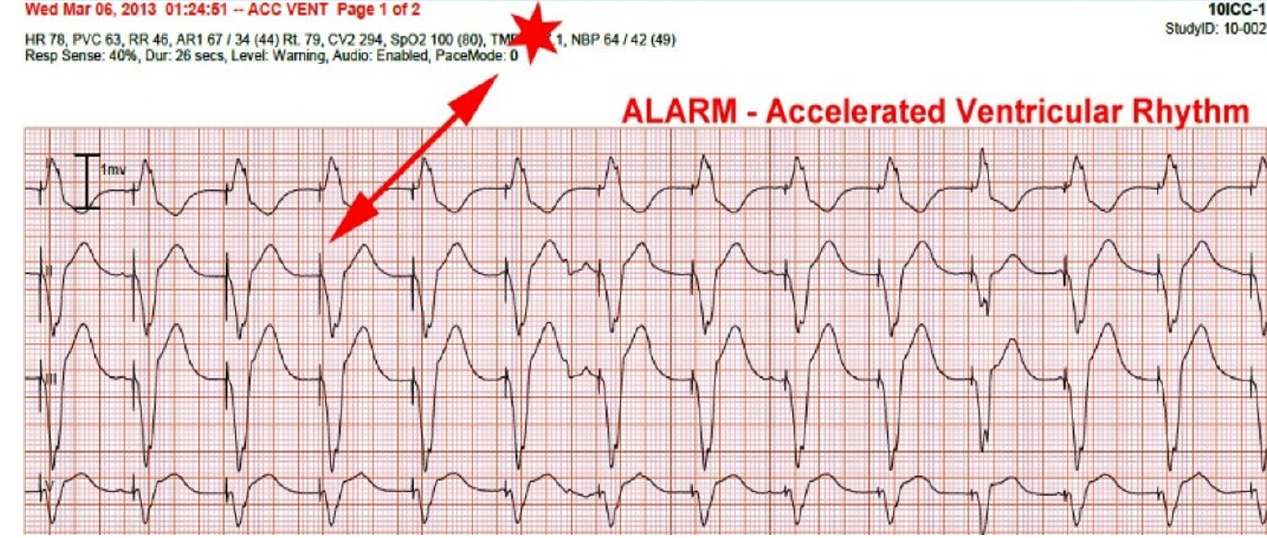
Figure 3. False alarm for accelerated ventricular rhythm defined as >6 ventricular beats with a heart rate between 50 and